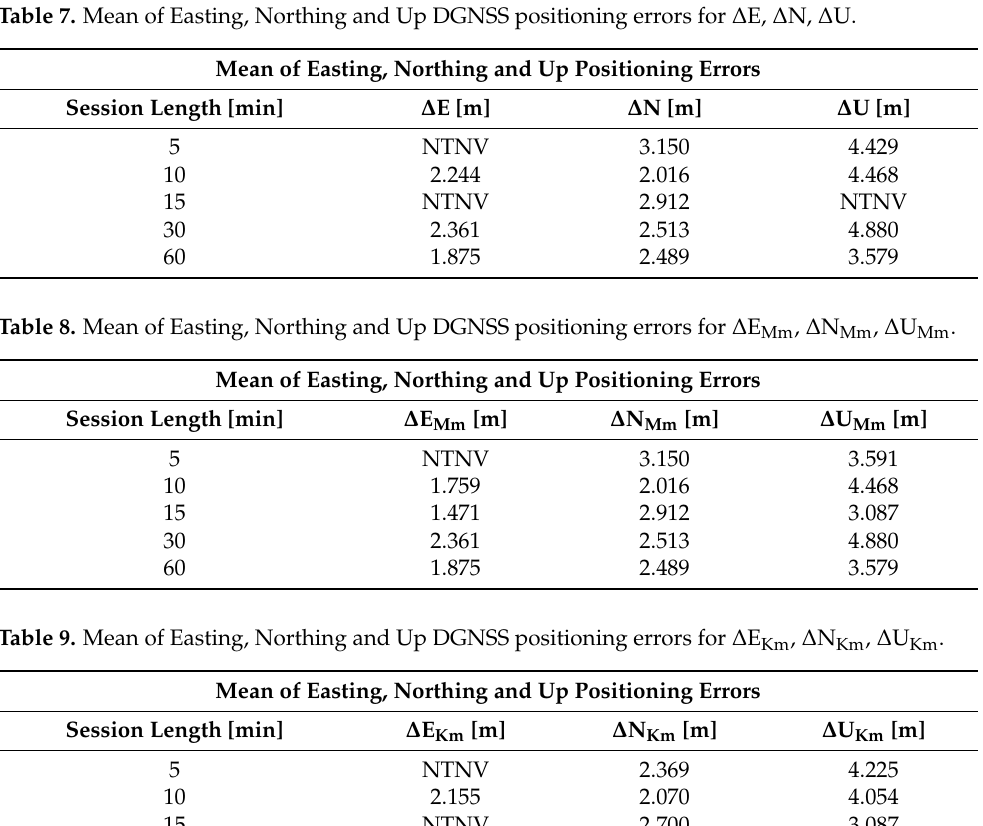
Table 7. Mean of Easting, Northing and Up DGNSS positioning errors for ∆ E, ∆ N, ∆ U.